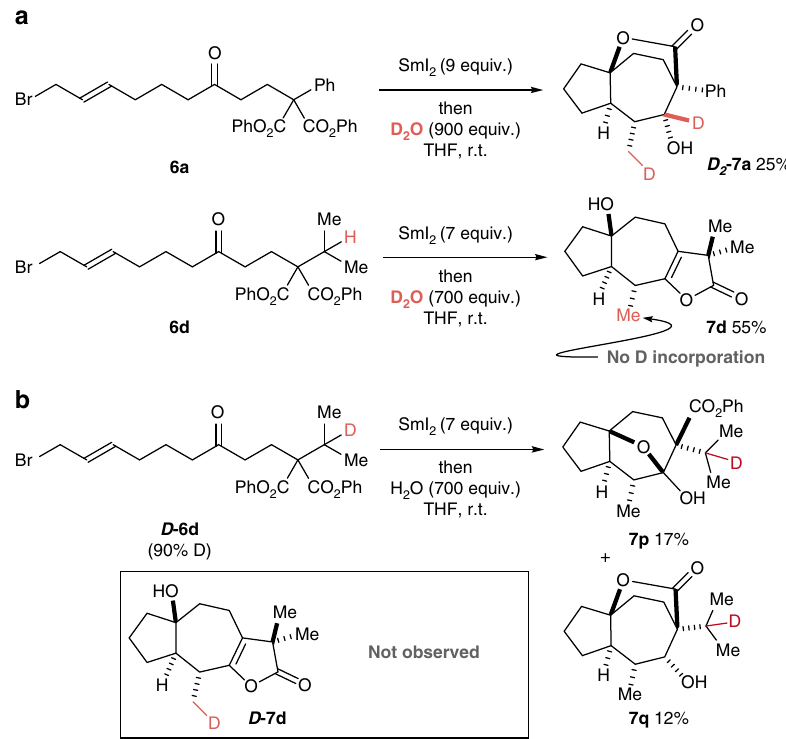
Fig. 6 Mechanistic studies. Mechanistic studies involving the use of a labelled additive and a labelled substrate are shown. a , Reaction with SmI 2 – D 2 O resulted in the formation of deuterated product D 2 - 7a . This observation supports the operation of the extended SET mechanistic pathway when 1,5-HAT in V is not possible. Treatment of substrate 6d with SmI 2 – D 2 O resulted in the formation of non-deuterated product 7d . This reaction outcome supports the operation of a mechanism involving activation of a secondary alkyl group by 1,5-HAT. b , Use of deuterated substrate D - 6d in the reaction resulted in the formation of products 7p and 7q (product D - 7d was not formed): The presence of deuterium in D - 6d blocked 1,5-HAT and redirected